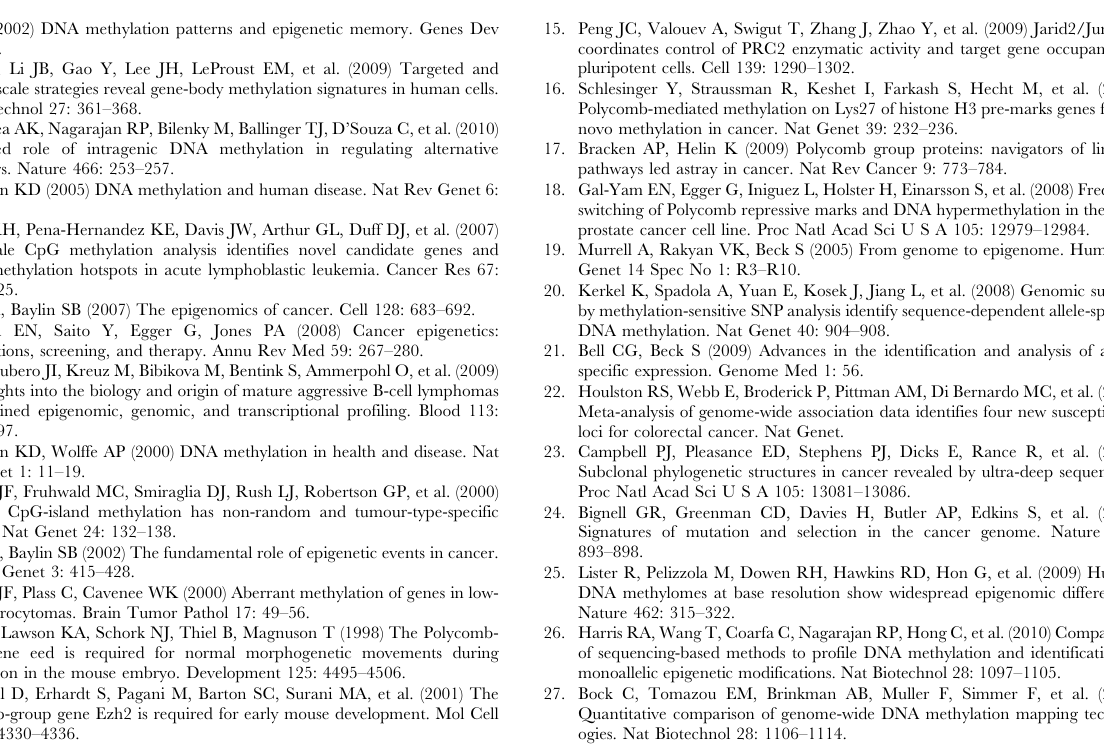
Table S3 The table provides a list of all methylated sites in the analyzed samples. Genomic coordinates refer to through a SNP are marked in underlined italics. Sites covered by ‘‘NA’’. The percentage of methylation is given for each site. Table S4 List of all polymorphic sites (SNVs and InDels) in the individual samples. The chromosome, chromosomal position, alleles and individual genotypes are provided for all samples. Table S5 The table provides an overview of the 18 manually designed pyrosequencing assays for the rep- lication of the measurement of DNA methylation at 17 selected loci. Note, that for the IGF2 locus, an assay on the forward and the reverse strand has been